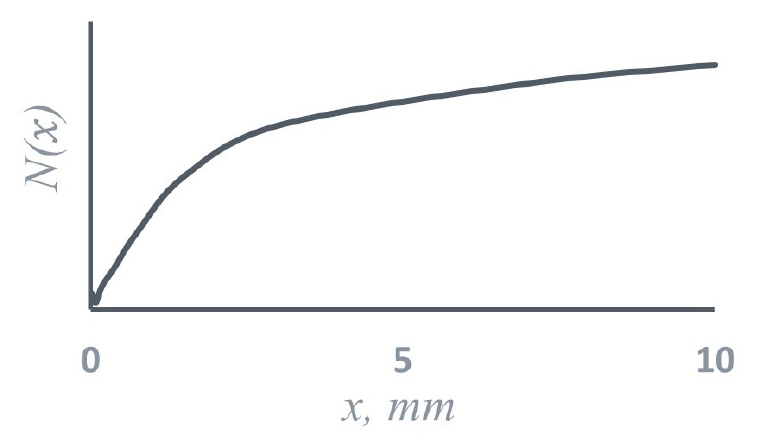
Figure 2. Relative distribution N ( x ) of particles by size x in tailings. Table 3 shows Fe grade in various size classes. Table 3. Fe grade in various size classes.